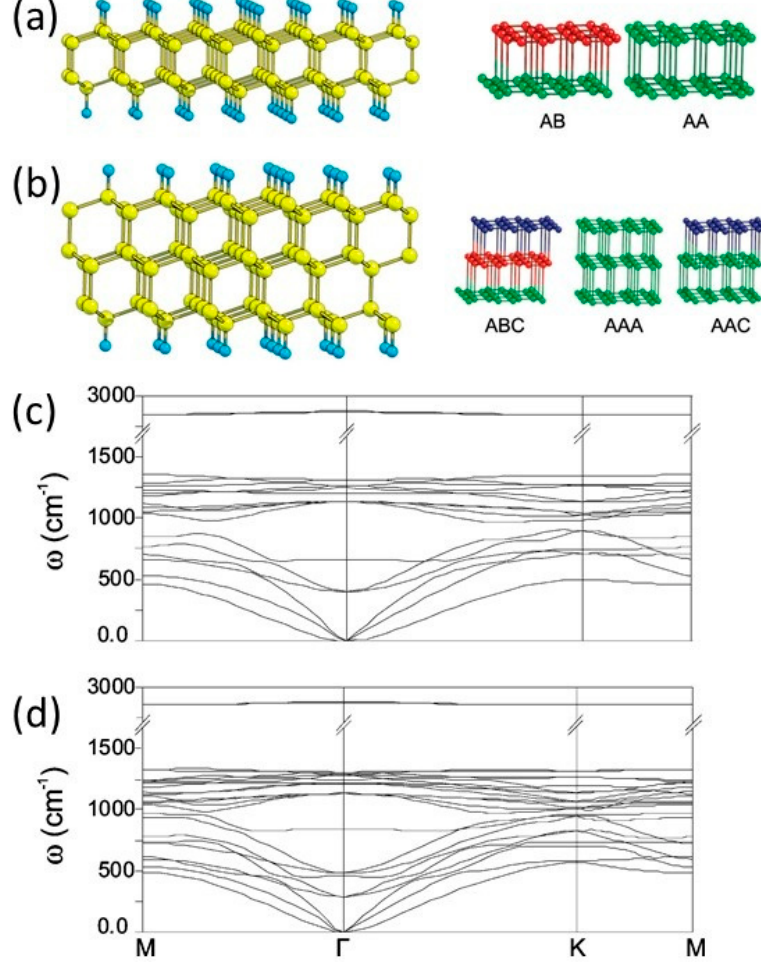
Figure 6. The atomic structure of two-dimensional diamond-like films formed from two and three graphenes: ( a ) diamane D(AB) with AB stacking of two graphene layers; ( b ) diamane D(ABC) with ABC stacking of three layers. Carbon atoms are marked in yellow (light gray); hydrogen is marked in blue (gray). Phononic band structures of each diamane are presented in ( c ) for D(AB) and ( d ) for D(ABC) [20].